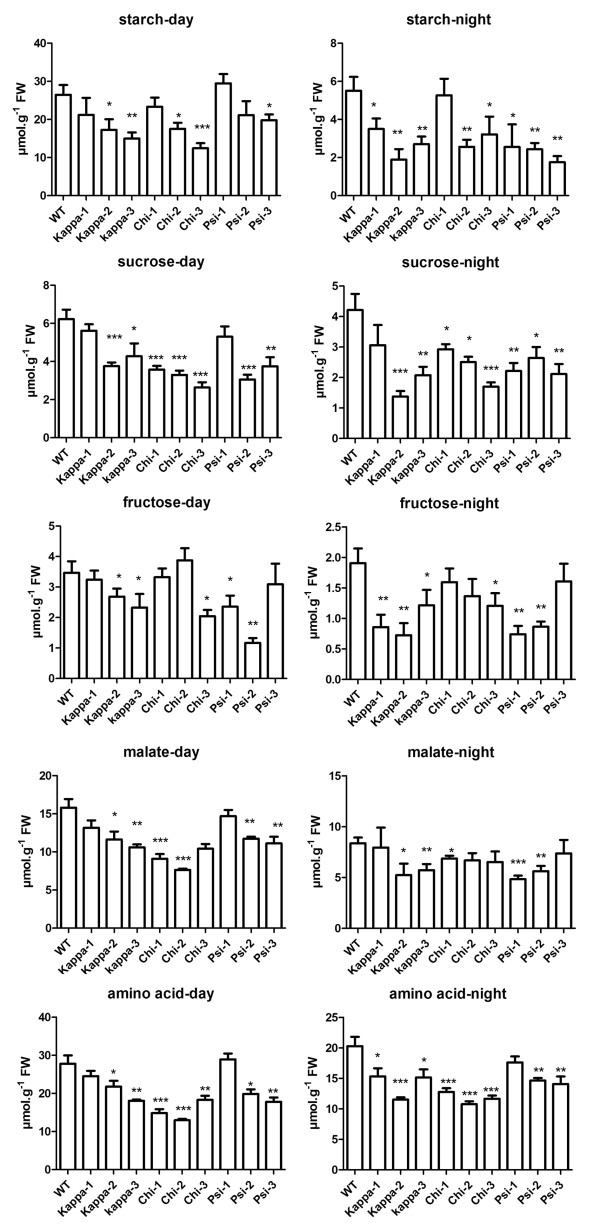
Major metabolite changes in 14-3-3 overexpression plants during day and night. The levels of starch, sucrose, fructose, malate and amino acids were significantly decreased in 14-3-3 overexpression plants compared to wild type (WT). Plants were harvested 1 h before switching light conditions. T-tests were performed to determine significant difference compared to WT (*, P < 0.05; **, P < 0.01; ***, P < 0.001).